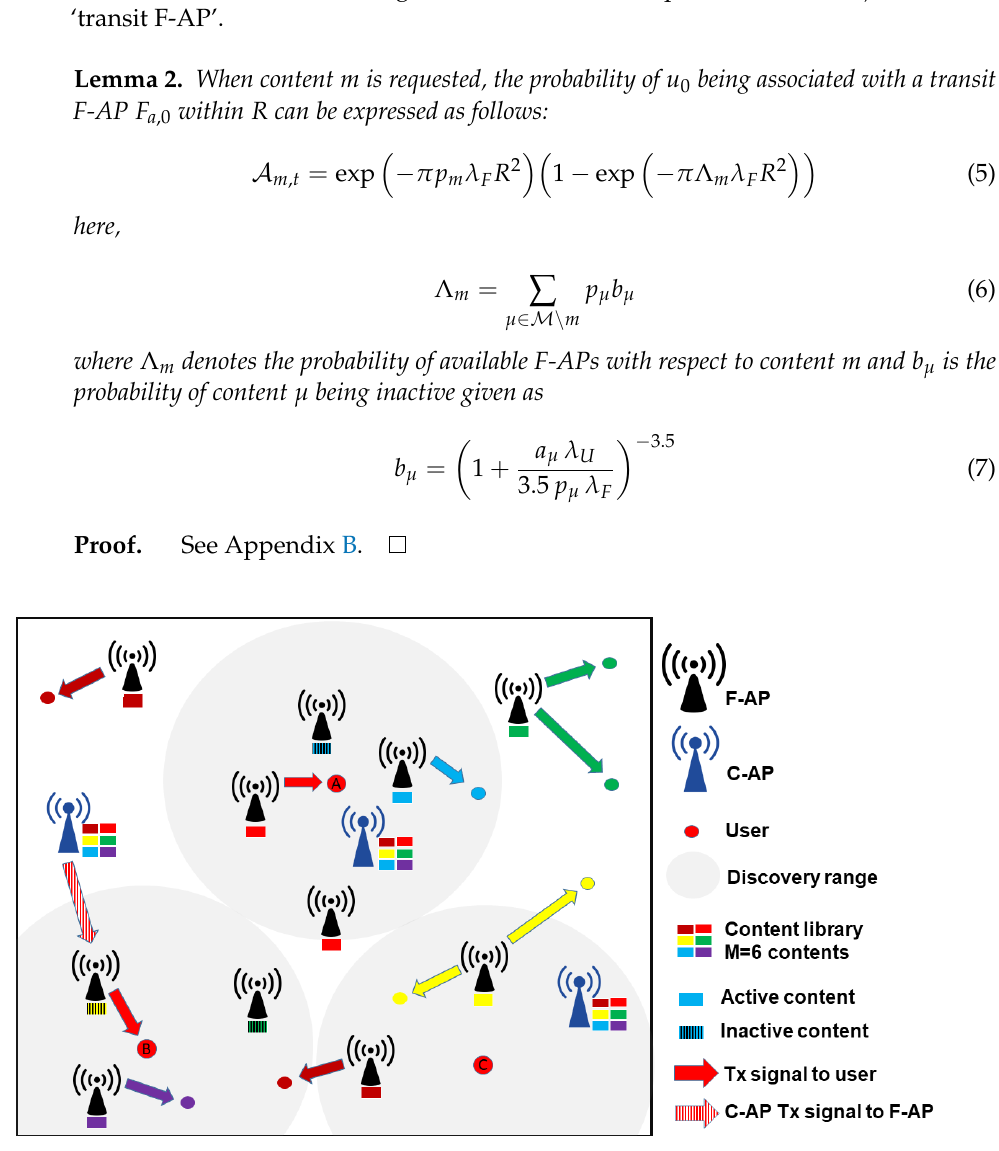
Figure 1. Illustration of the association